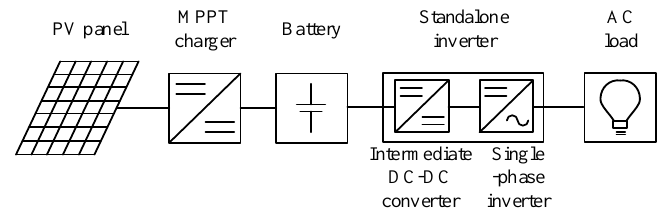
Figure 1. Configuration of the Standalone PV Systems.